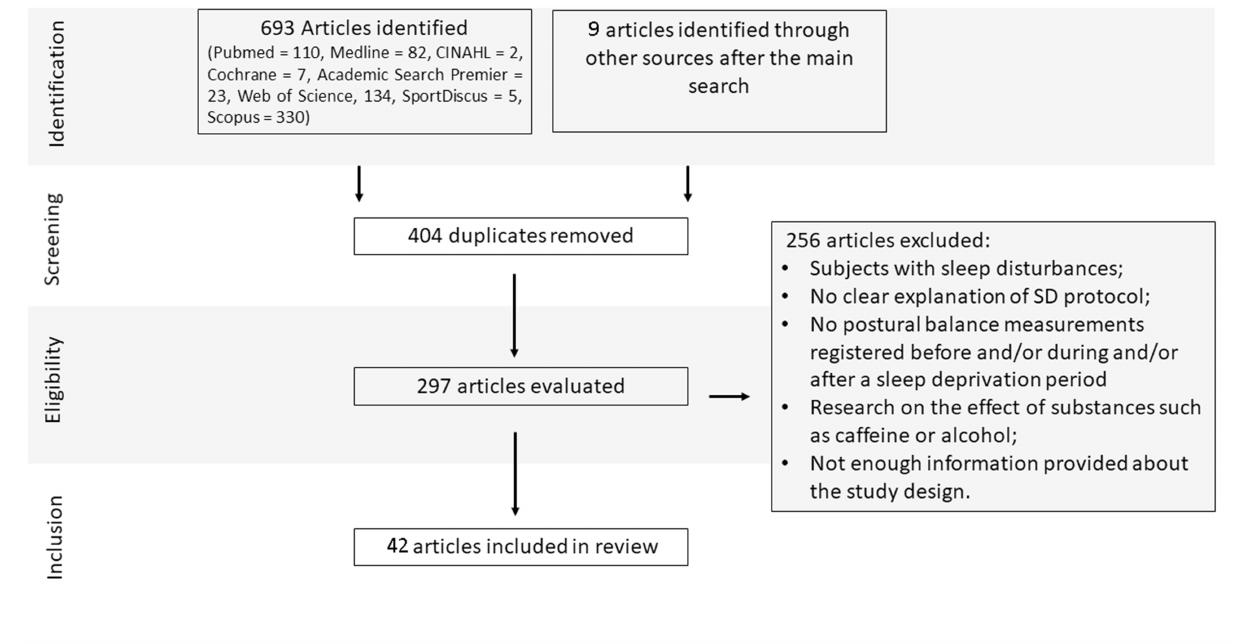
scores ranged from 15 to 24 and all the papers were thus retained for the review ( Supplementary Table 1